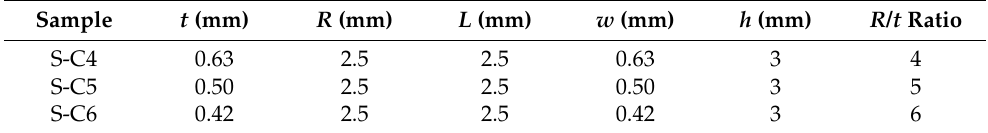
Table 1. The dimensions of the identical unit cells.